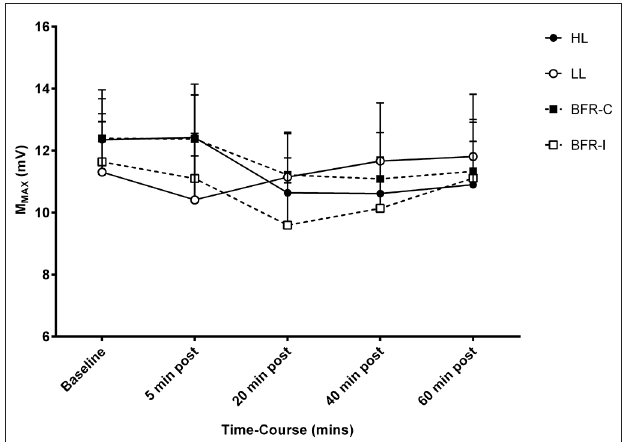
FIGURE 2 | M MAX amplitude following resistance exercise . HL, heavy-load resistance exercise; LL, light-load resistance exercise; BFR-C, blood flow restriction with continuous inflation of cuff pressure; BFR-I, blood flow restriction with intermittent inflation of cuff pressure. MEP amplitude at 5 min post-exercise following LL ( p ≤ 0.001),